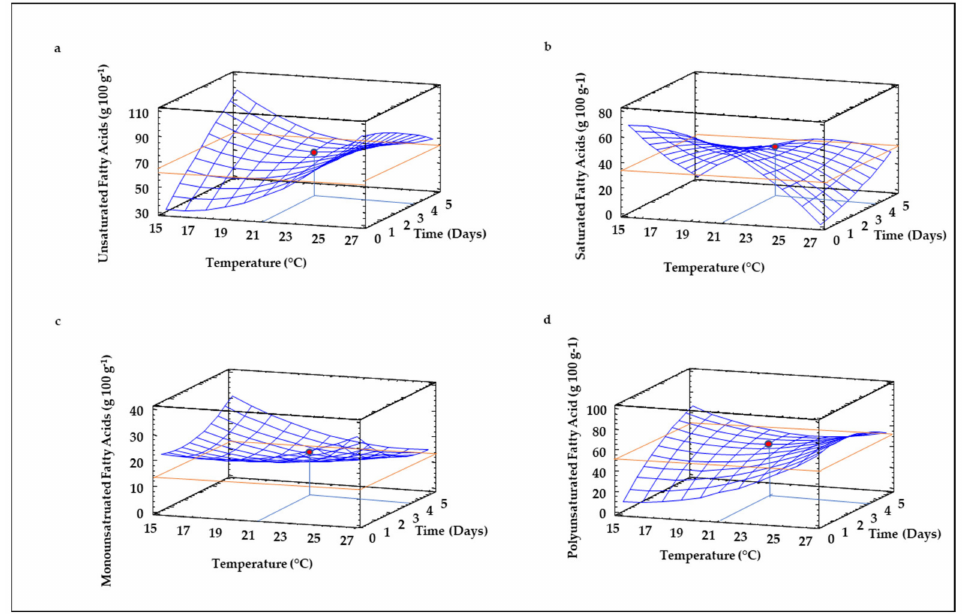
Figure 2. Three-dimensional Response Surface Plots for relative percentage of unsaturated fatty acids ( a ), saturated fatty acids ( b ), monounsaturated fatty acids ( c ) and polyunsaturated fatty acids ( d ) as a function of the interaction between germination temperature and time. The red line corresponds with the control (ungerminated seed) and the red point with the value for optimum conditions (21 ◦ C and 3.5